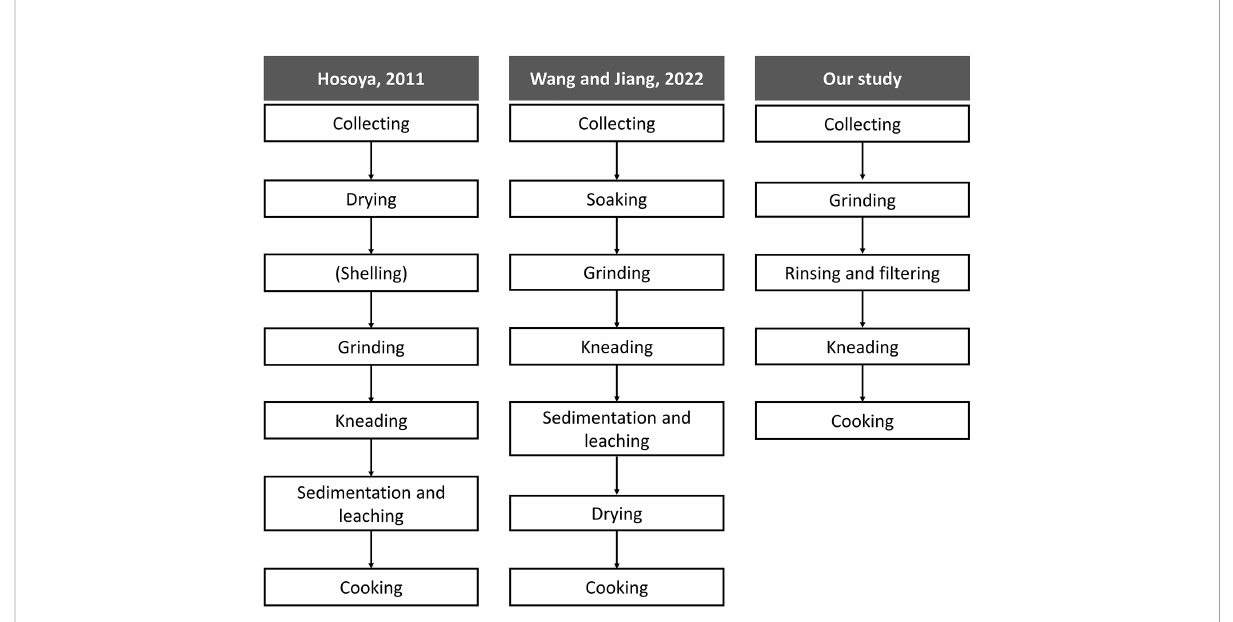
FIGURE 5 Comparison of three Cha ı ̂ ne Ope ́ ratoires of starch